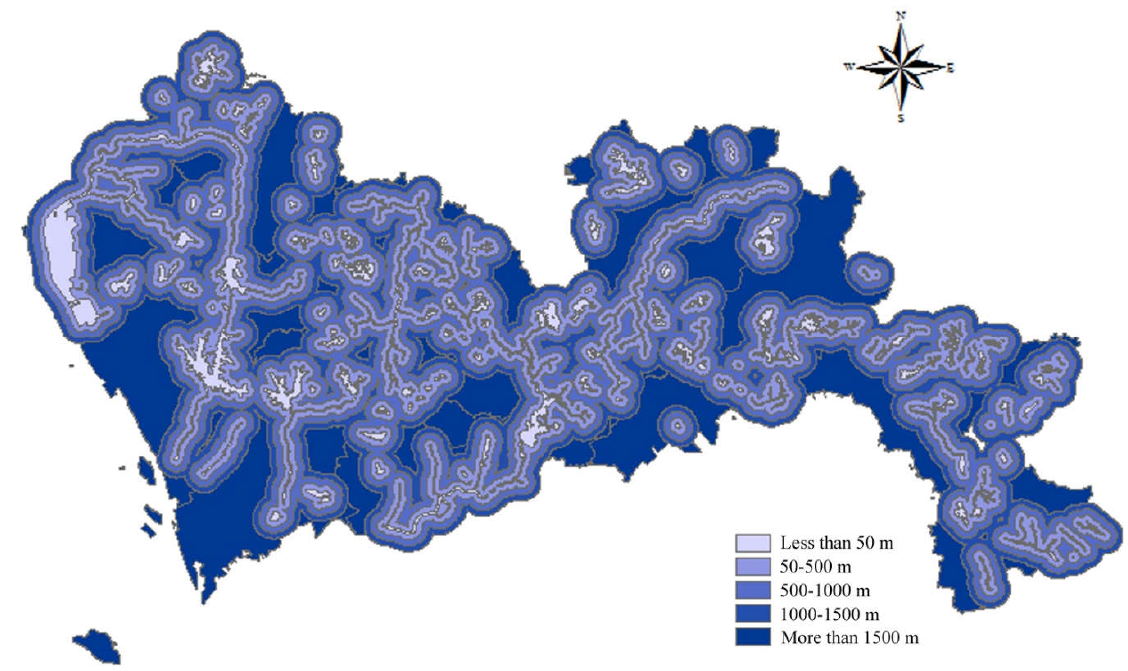
Figure 1. Map of distance to surface water.